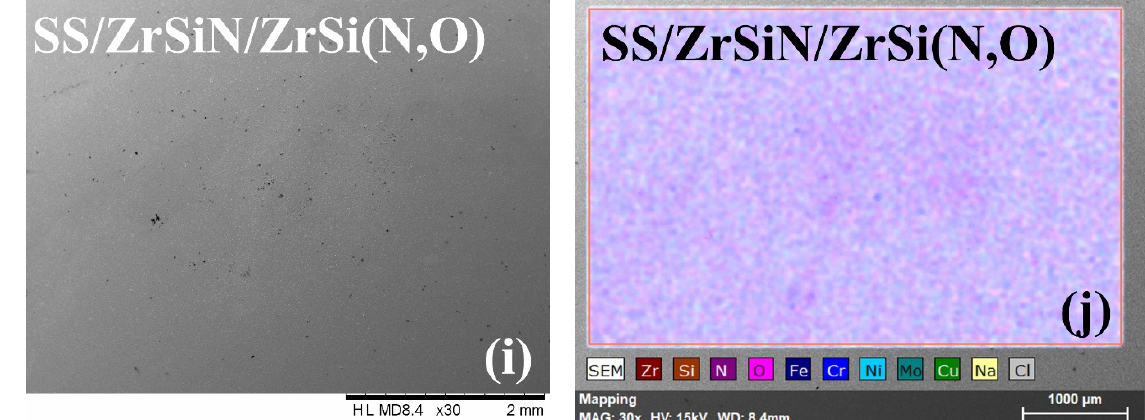
Figure 6. SEM micrographs and element distribution of all investigated specimens after the corrosion test. SEM images: SS ( a ), SS/ZrSiN ( c ), SS/ZrSi(N,O) ( e ), SS/ZrSi(N,O)/ZrSiN ( g ), and SS/ZrSiN/ZrSi(N,O) ( i ). EDS images: SS ( b ), SS/ZrSiN ( d ), SS/ZrSi(N,O) ( f ), SS/ZrSi(N,O)/ZrSiN ( h ), and SS/ZrSiN/ZrSi(N,O) ( j ).